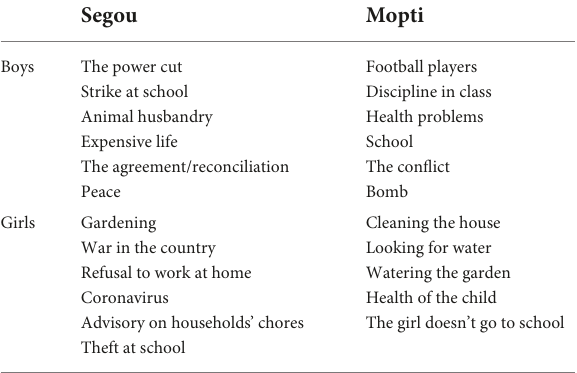
TABLE 1 Themes presented in the cellphilms by region and gender. Segou